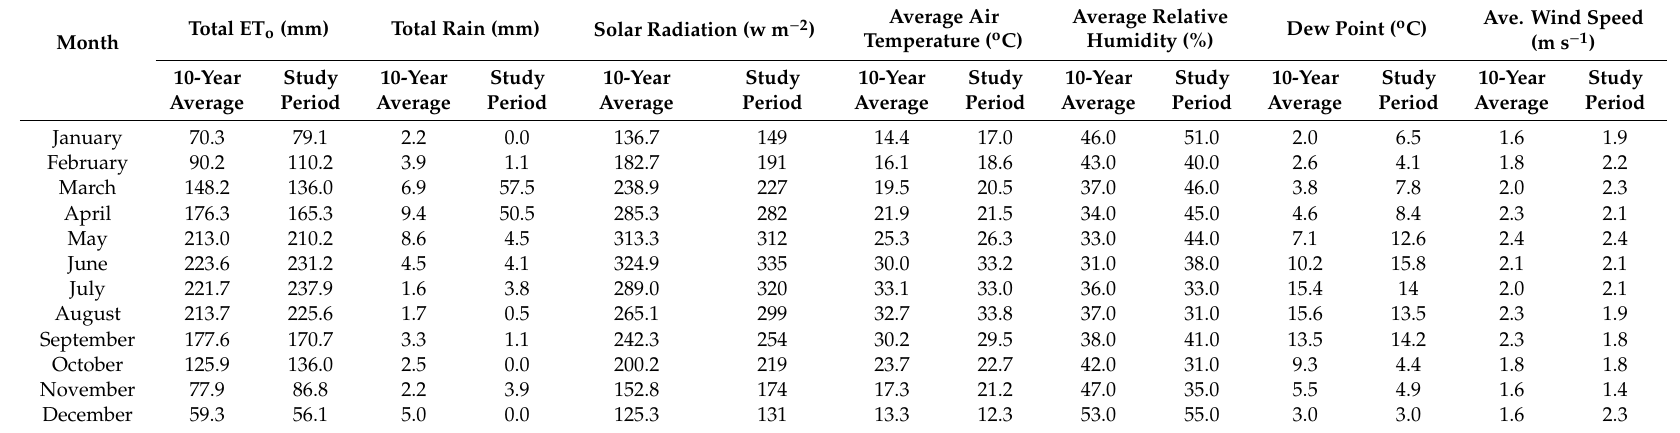
Table 3. Monthly mean long-term climate data versus monthly data of the study period for Oasis # 136 California Irrigation Management Information System (CIMIS) station. The mean monthly data of a 10-year period (2009–2018) is reported as long-term climate data, and the monthly data of May 2019 through April 2020 is reported as this study